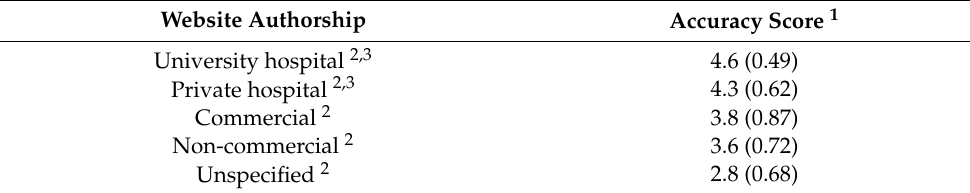
Table 6. Accuracy scores by website